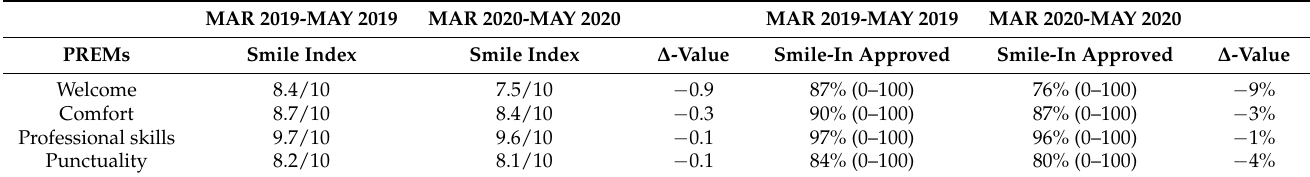
Table 3. Data analysis related to the period before and after the COVID-19